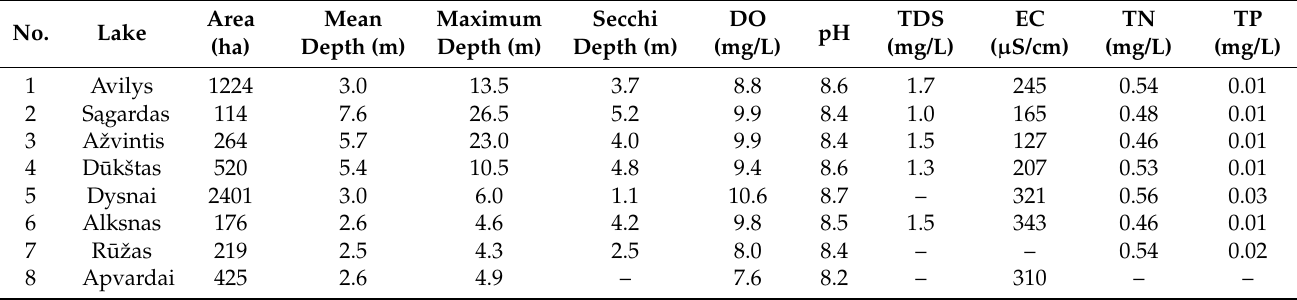
Figure 1. Position of Lithuania in Europe ( a ). A rectangle delineates the northeastern region of Lithuania ( b ). Lakes where the target species were found are marked by red dots ( c ): Najas flexilis in lakes Avilys (1), Ažvintis (2) , Sągardas (3) , and Dūkštas (4); Aldrovanda vesiculosa in lakes Dysnai (5) and Alksnas (6); Aldrovanda vesiculosa and Caldesia parnassifolia in lakes Rūžas (7) and Apvardai (8). Most of the studied lakes belong to the Daugava River basin, except for Lake Dūkštas , Table 1. Hydromorphological characteristics of studied lakes and physicochemical parameters of their water [60]. Physicochemical properties of water were determined in 2007 (Lake Apvardai), 2017 (Lakes Avilys and R¯užas), 2019 (Lakes Dysnai and Alksnas), 2020 (Lake D¯ukštas), and 2021 (Lakes S ˛agardas and Ažvintis). Abbreviations: DO, dissolved oxygen; TDS, total dissolved substances; EC, electric conductivity; TN, total nitrogen; TP, total